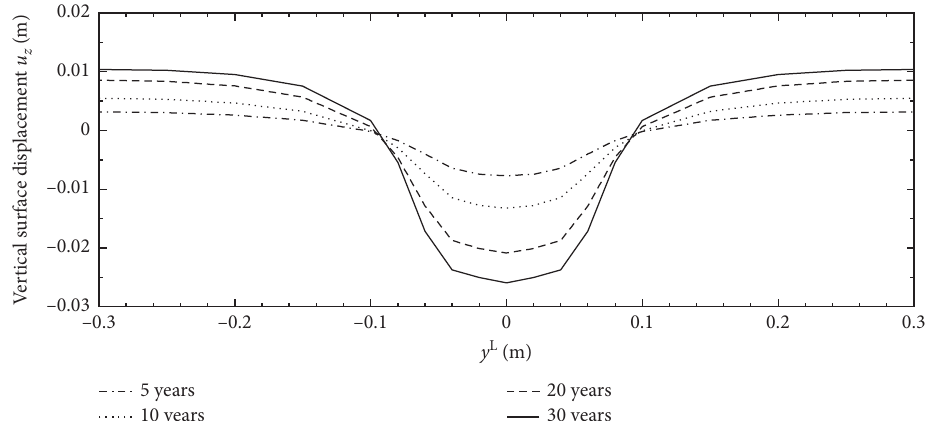
Figure 6: Deformed surface of the test track (cross-sectional direction) plotted for a global time of 5 years, 10 years, 20 years, and 30 years (number of load cycles � about 7 · 10 7 per year) [27].